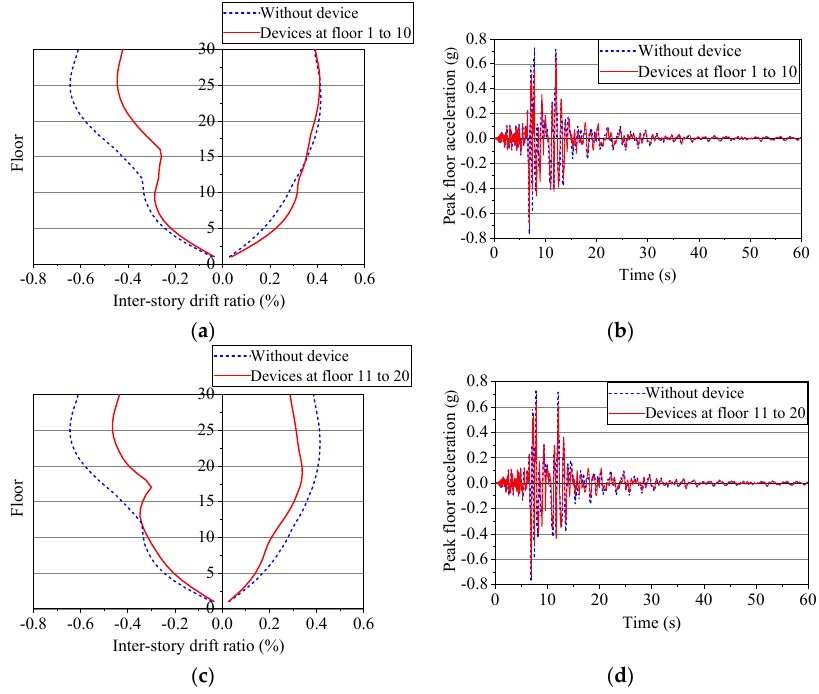
Figure 21. Behavior of structures: ( a ) Inter-story drift and ( b ) Floor acceleration on 30th floor: devices on floors 1 to 10; ( c ) Inter-story drift and ( d ) Floor acceleration on 30th floor: devices on floors 11 to 20.